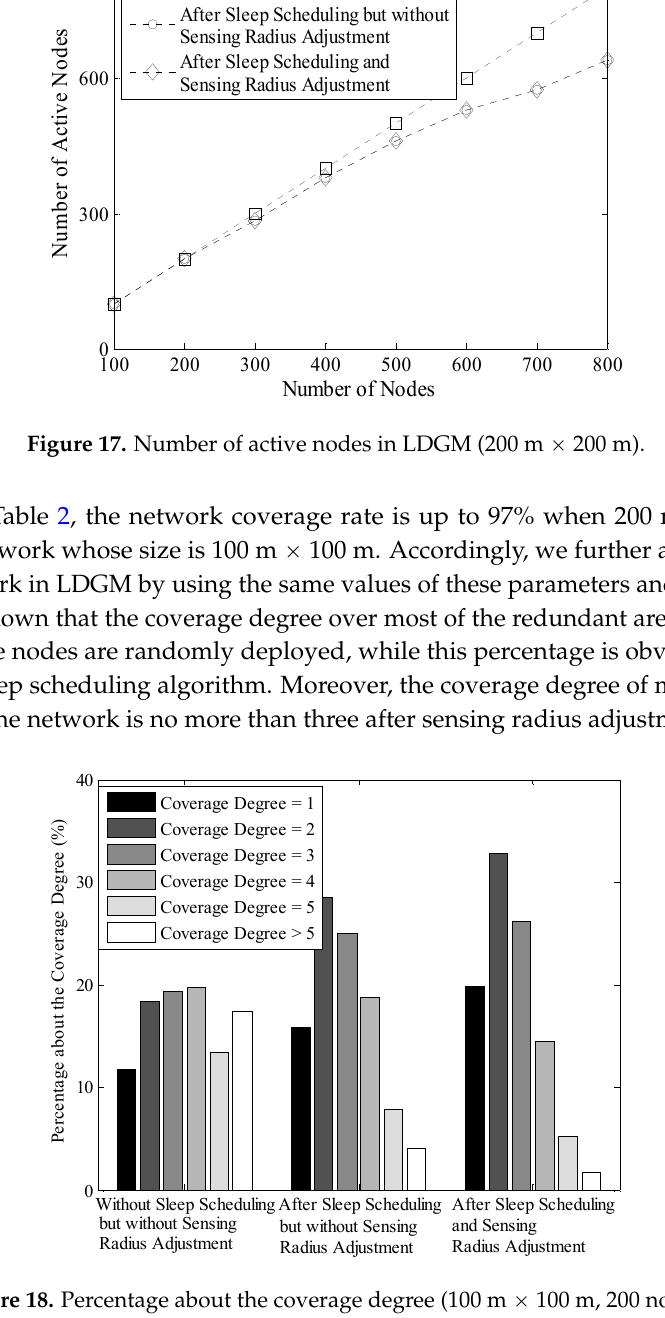
Figure 16. Redundancy on coverage (200 m × 200 m).